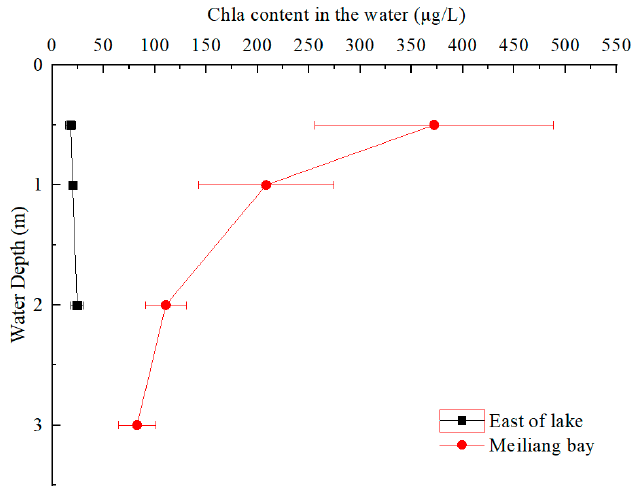
Figure 2. Contents of Chla in the water layers of Taihu Lake.